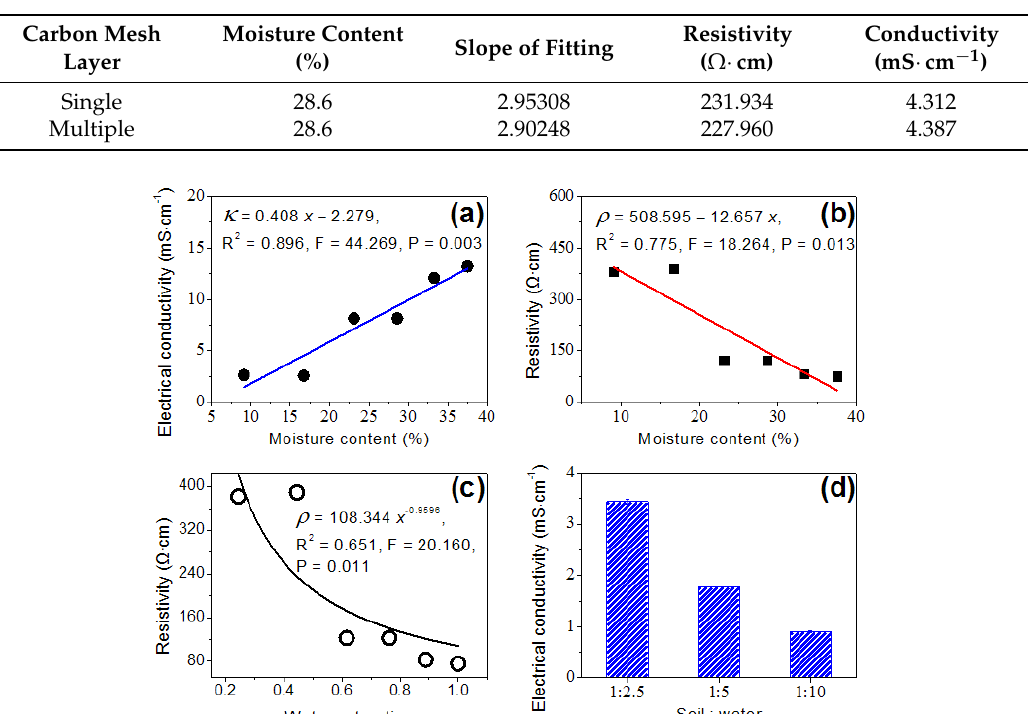
Figure 5. Electrical conductivity ( a ); resistivity ( b , c ) as the function of soil moisture contents and water saturation (water content/saturated water content); and the soil electrical conductivity ( d ) measured by using conductivity meter at different ratios of soil to water.